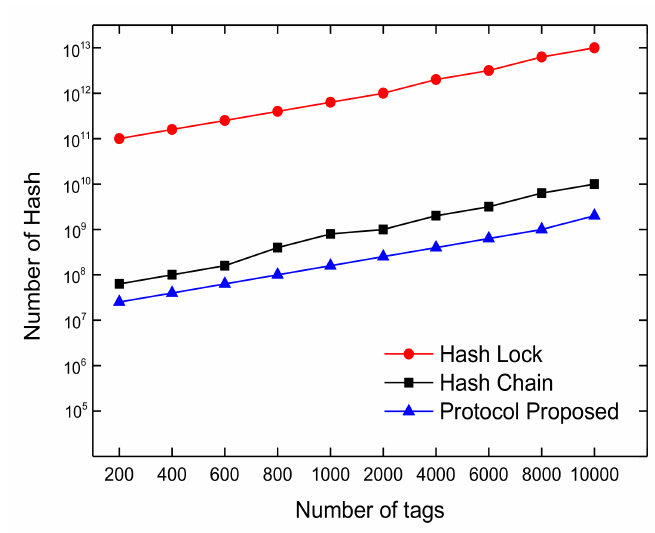
Figure 5. The number of hash computing